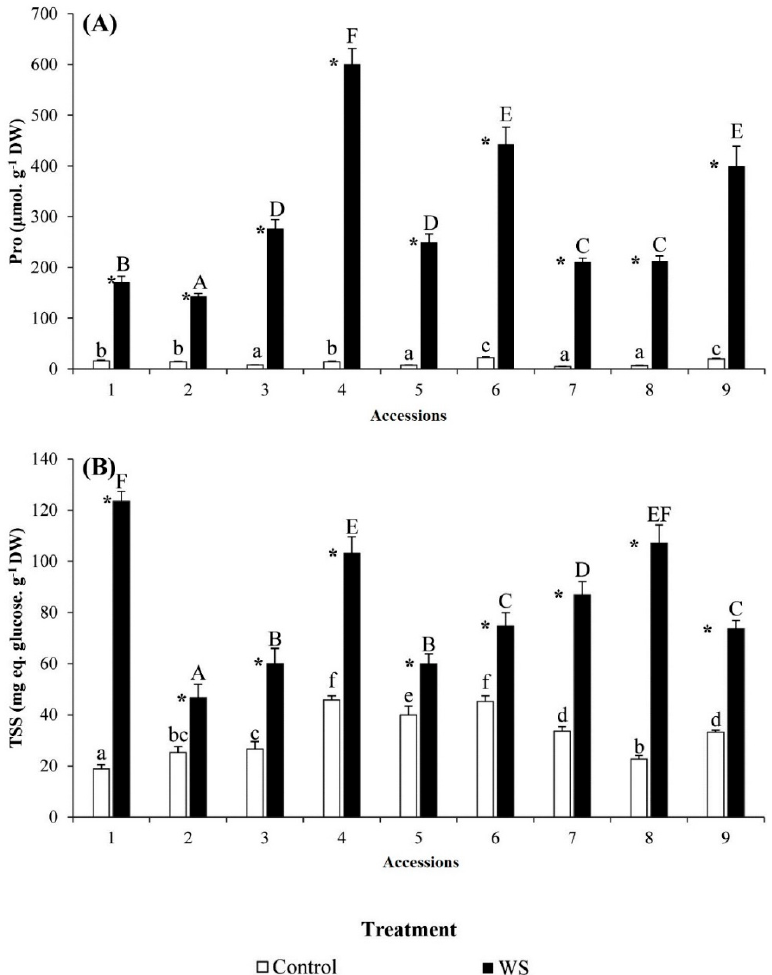
Figure 3. Variation in osmolytes concentrations in the nine accessions of “Ardhaoui” barley landraces after three weeks of water stress (WS) treatment: ( A ) proline (Pro); and ( B ) total soluble sugars (TSS). Error bars indicate SE ( n = 5). For each accession, asterisks (*) indicate significant differences between control and WS treatments and different letters indicate significant differences among accessions undergoing the same treatment, according to the Tukey test ( α = 0.05).